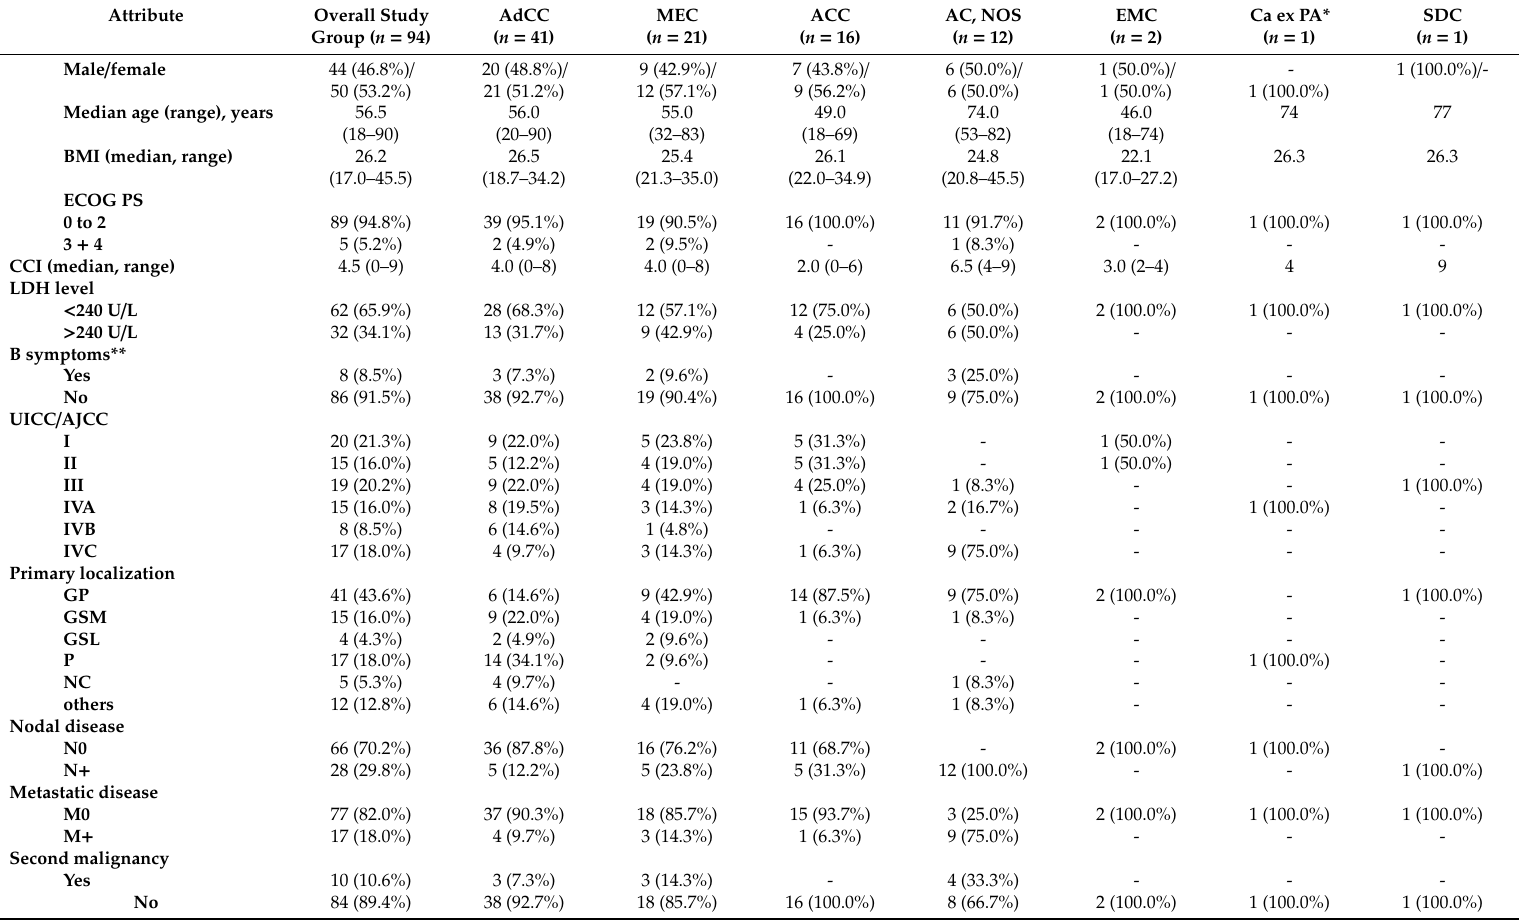
Table 1. Baseline characteristics for all patients included in the